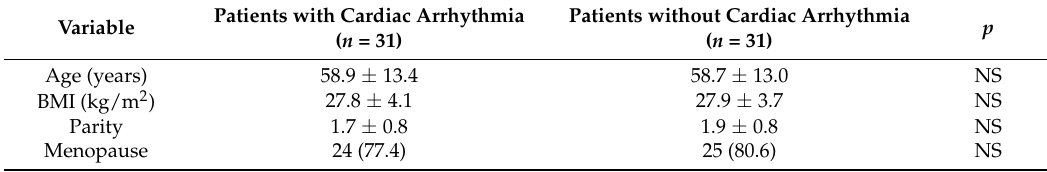
Table 2. Demographic characteristics of overactive bladder (OAB) patient groups.